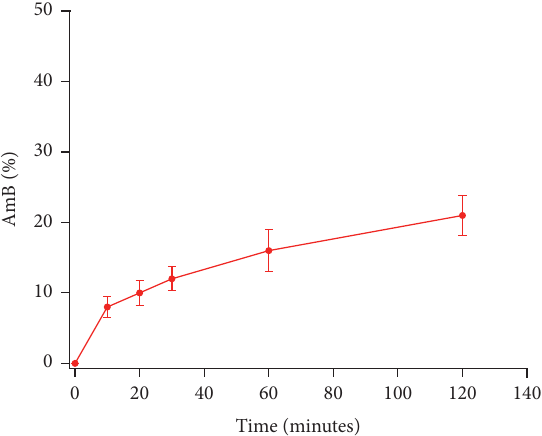
Figure 3: Release profile of AmB-loaded MCPs. Error bars represent standard deviation of three independent experiments.